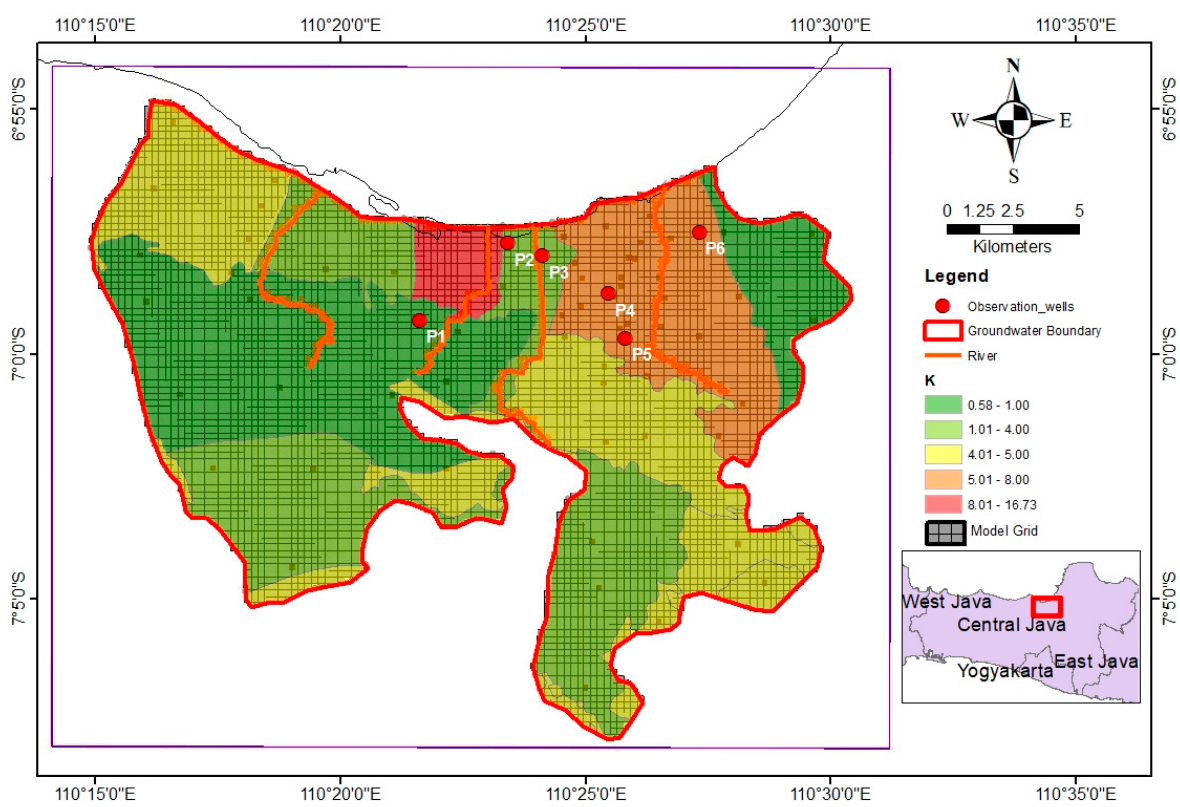
Figure 5. Model grid, hydrogeological polygon zones, rivers, and observation wells of the Semarang groundwater basin. There are 54 observation wells that are scattered around Semarang City.